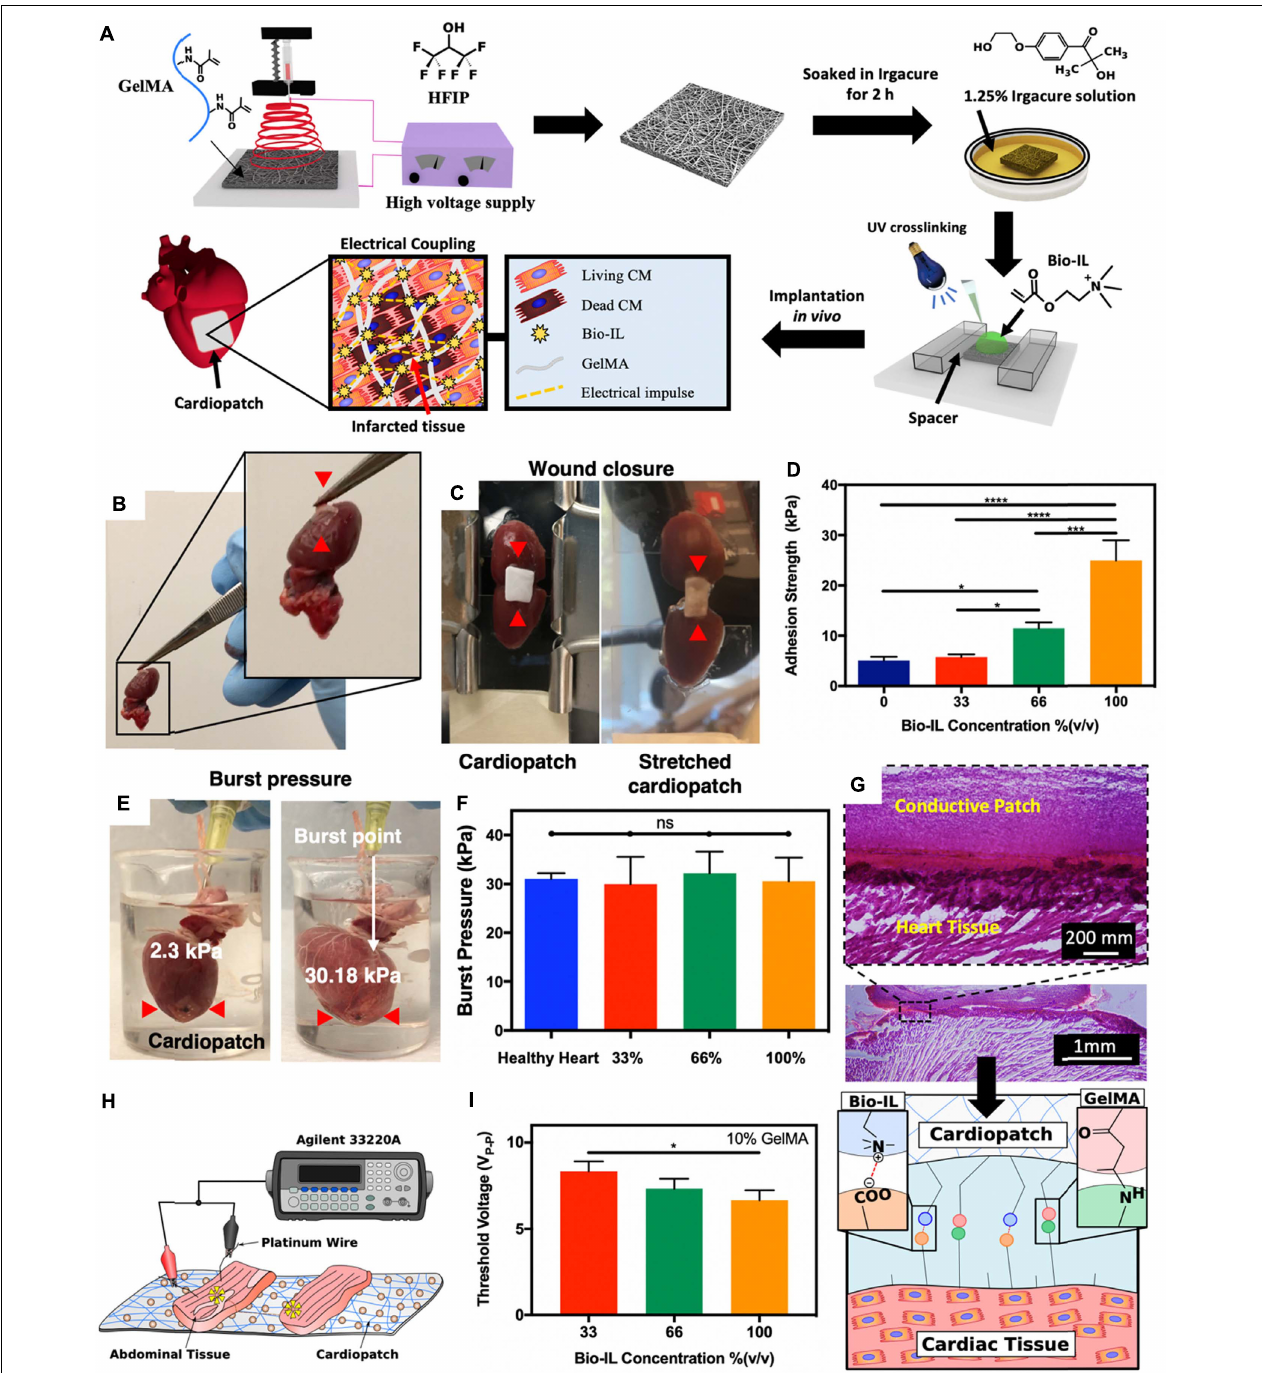
FIGURE 7 | Application of adhesive tissue engineering scaffolds (ATESs) in cardiac tissue repair. (A) Fabrication of electrospun cardiopatches, soaking in Irgacure solution, addition of Bio-IL, followed by UV crosslinking for 5 min. (B) GelMA/Bio-IL cardiopatch photo-crosslinked on explanted rat heart, demonstrating adequate adhesion (red arrows) to the heart tissue. (C) Wound closure test to test the adhesion strength of cardiopatches on the explanted rat heart (as substrate). (D) Quantification of the patch adhesion strength, consisting of 10% (w/v) gelMA and at varying concentrations of Bio-IL. (E) Images of gelMA/Bio-IL cardiopatch with 10% gelMA and 66% Bio-IL, crosslinked onto the defect site of explanted rat heart, to measure the burst pressure. (F) Quantification of the burst pressure. (G) H&E staining of patch-tissue interface, demonstrating a strong bonding of the hydrogel to the murine myocardium. (H,I) Ex vivo analysis of the threshold voltage of gelMA/Bio-IL cardiopatches at varying Bio-IL concentrations. * P < 0.05, **** P < 0.001 and **** P < 0.0001. Reconstructed with permission from Walker et al. (2019).